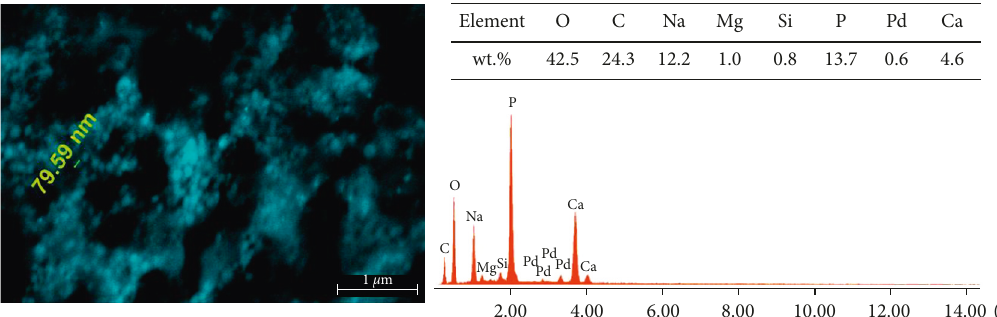
Figure 3: High-contrast SEM image and EDX analysis of the surface of Pd/NPs.